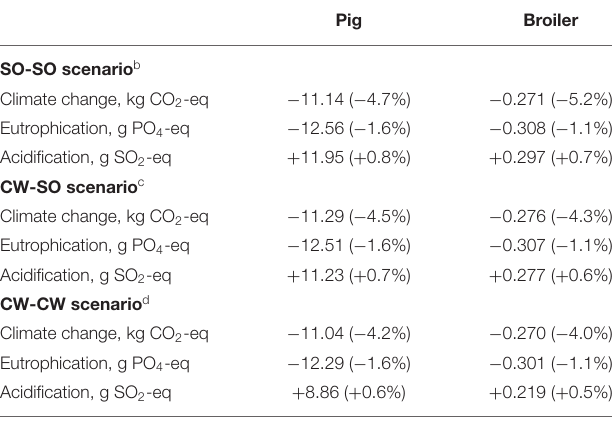
TABLE 8 | Changes in the environmental impacts associated with β -mannanase supplementation when the total amount of feed used to raise a pig or a broiler (from hatch/weaning until slaughter, excluding breeding phases) is considered in the simulation a .